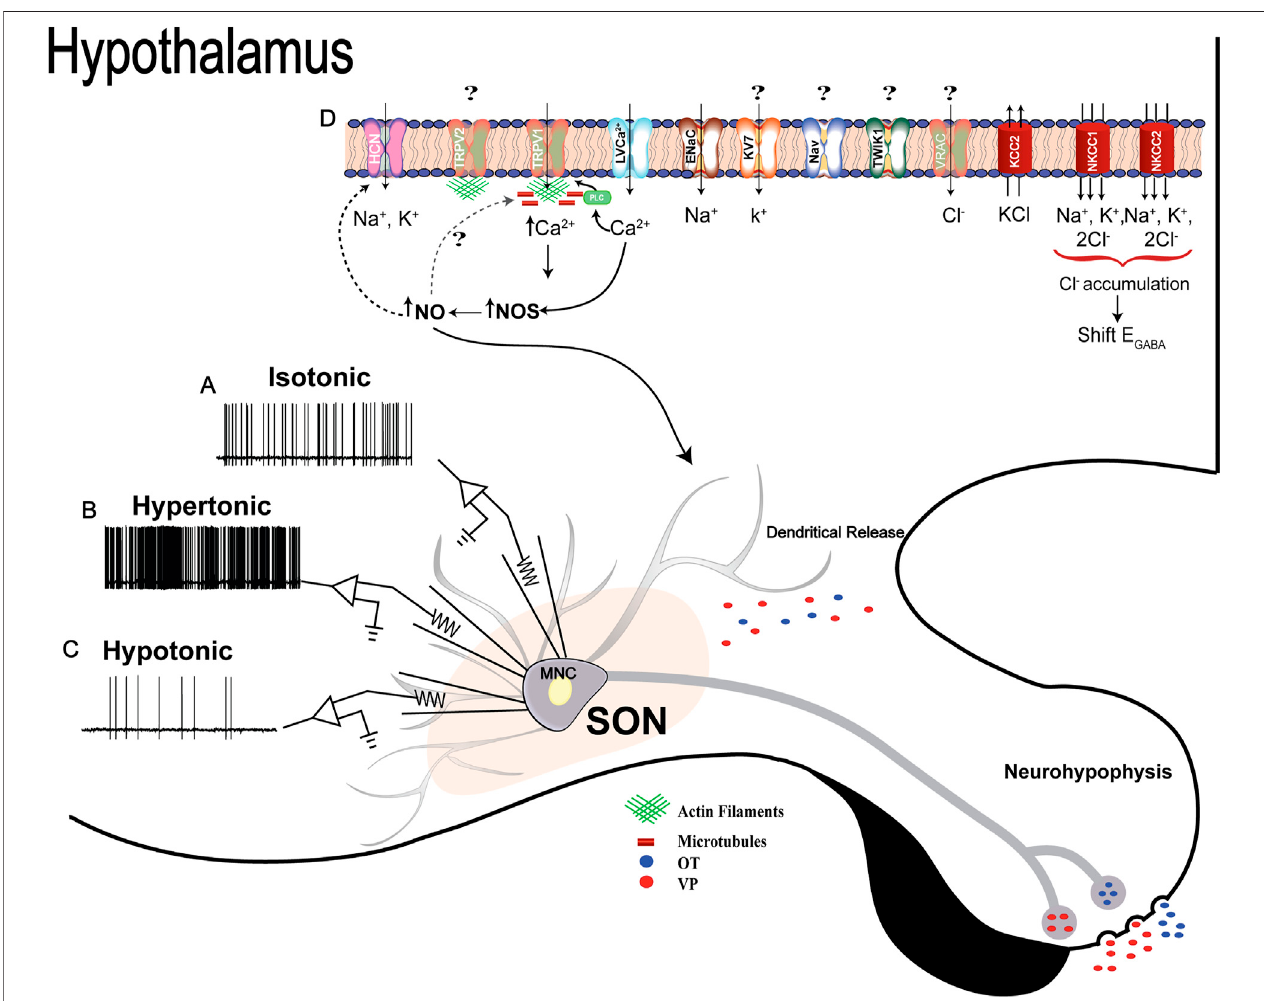
FIGURE 4 | Osmosensitivity of MNCs: (A, B , and C) , representative traces of intrinsic electrical responses of one MNC in isotonic, hypertonic or hypotonic conditions, respectively, measured using the whole-cell patch-clamp technique. The MNC increases its fi ring frequency in hypertonic challenges, while the opposite effect is observed during a hypotonic stimulation. The electrical activity of MNCs is directly correlated with neuropeptide secretion, so an increase in AVP and OTX secretion during hypertonicity and a decrease in hypotonicity are expected. Osmotic challenge also triggers AVP and OTX release as a self-regulatory mechanism (details described in the text). (D) Schematic representation of ion channels, transporters, and intracellular events recruited after osmotic challenges in MNCs. Although Δ N-TRPV1 has been described as the main molecular mechanism coupling hyperosmolality to electrical responses in the MNCs, Trpv2 was described as the main ion channel gene upregulated in the SON. However, there is no available evidence about the participation of TRPV2 in the MNCs ’ osmosensitivity. While microtubules and actin fi laments are essential for Δ N-TRPV1 channel activation, TRPV2 seems to interact only with actin fi laments. HCN channels, mainly type 3, are also involved in controllingMNCs ’ electrical propertiesinhypertonicconditions, and theirconductance ismodulated bynitric oxidein anS-nitrosylated-dependent mechanism. Sodium non-voltagedependentchannelsarealsopartofthemechanismscontrollingtheexcitabilityofMNCswhentheextracellular fl uidhomeostasisisdisturbedbyincreasesin extracellular Na + . Potassium voltage-dependent channels (KV7/M-type), in turn, are activated to shape the fi ring pattern of the neurons during an osmotically evoked activity. Evidence about transporters ’ participation in osmoregulation has also emerged. NKCC1, NKCC2 and KCC2 are the principal elements involved. These transporters act in synchrony with several ion channels, particularly chloride (VRAC), to couple changes in osmolality and cell volume of MNCs to the electrical phenomena. Numerous ion channels and transporters also seem to be involved, but further studies are necessary to discover their possible regulatory function in the MNCs stimulus-synthesis-secretion